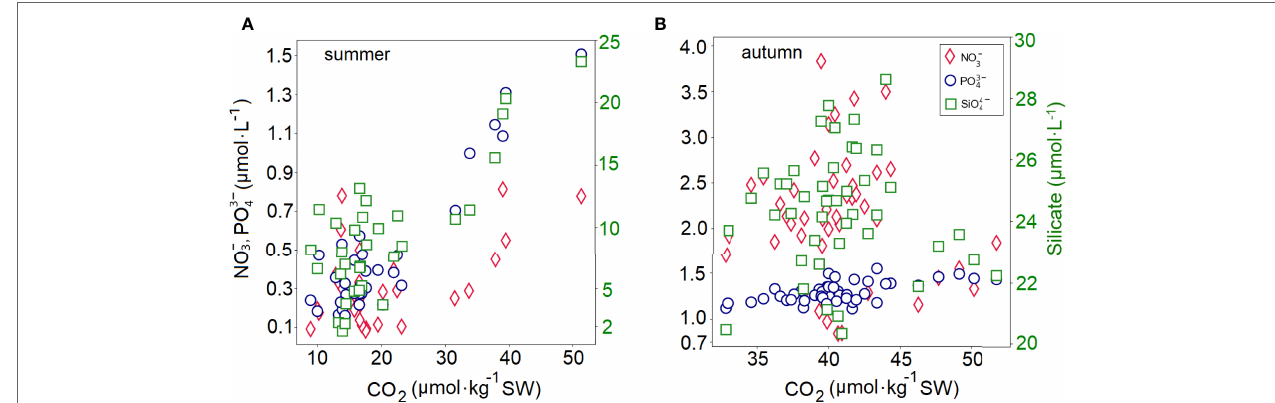
FIGURE 8 | Dynamics of in situ concentration of dissolved CO 2 gas in the water sample (calculated using the CO2Sys) vs nutrients during the (A) summer and (B) autumn